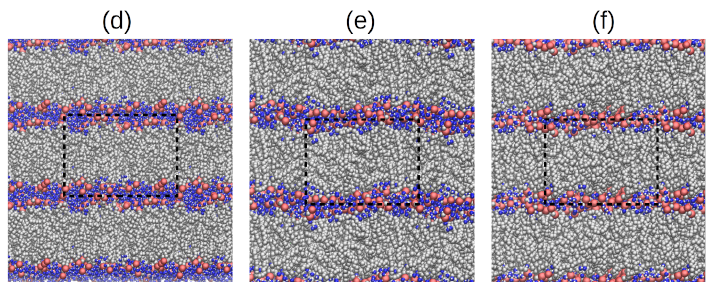
Figure 1. Snapshots of the six systems considered in our study, with hydration levels ( a ) 34; ( b ) 20; ( c ) 15; ( d ) 10; ( e ) 7; and ( f ) 4. Gray and red beads represent phospholipid tails and headgroups, respectively. Blue and white beads represent oxygen and hydrogen atoms of water. The dashed line indicates the size of the simulation box.